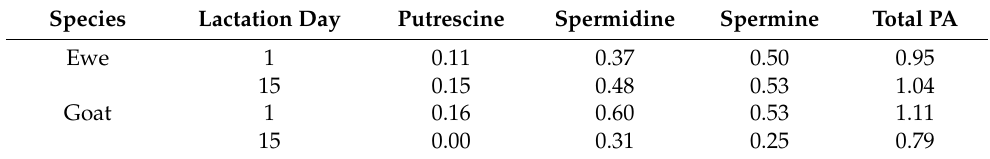
Table 9. Polyamine (PA) concentration in ewe and goat colostrum and mature milk ( µ mol/L). Species Lactation Day Putrescine Spermidine Spermine Total PA Ewe 1 0.11 0.37 0.50 0.95 15 0.15 0.48 0.53 1.04 Goat 1 0.16 0.60 0.53 1.11 15 0.00 0.31 0.25